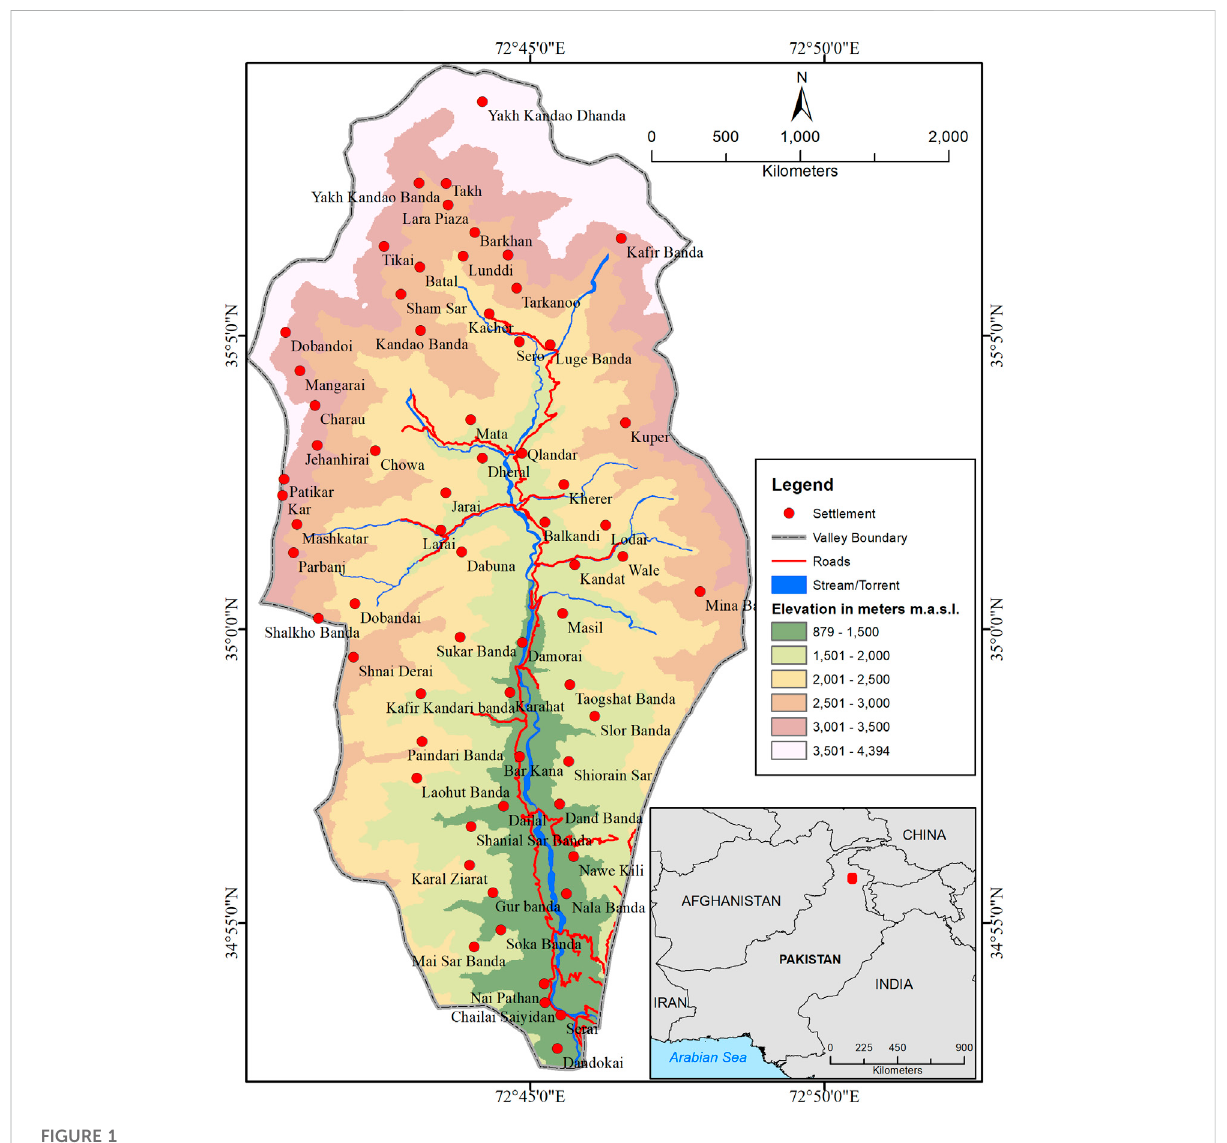
FIGURE 1 Digital elevation map of Shahpur